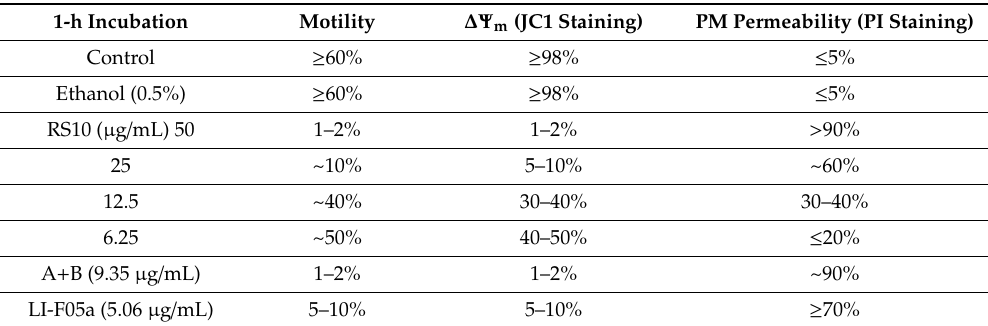
Table 2. Damage to boar spermatozoa caused by the RS10 extract and purified fusaricidins A + B and LI-F05a (HPLC fractions 2 and 3, respectively).